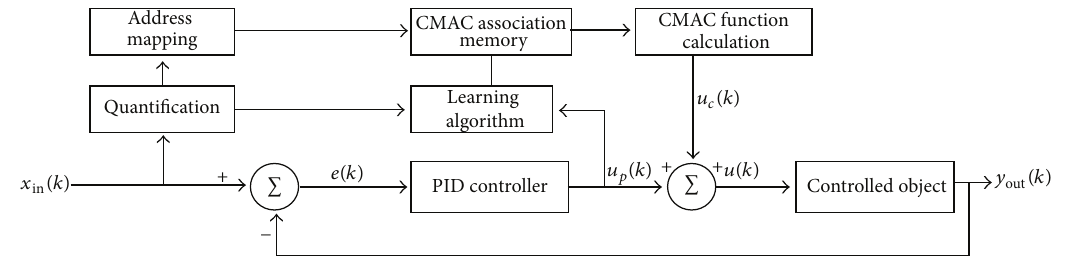
Figure 1: The structure diagram of self-tuning parameter PID controller based on CMAC.